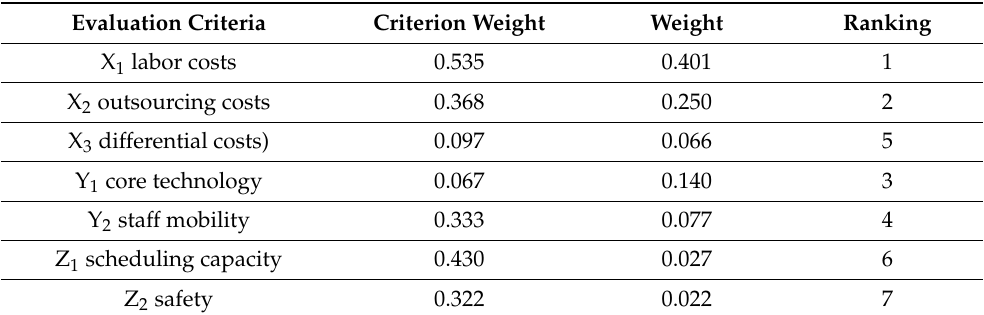
Table 7. The criterion weight, weight, and ranking of evaluation criteria in the 3rd layer with four lines as an example.